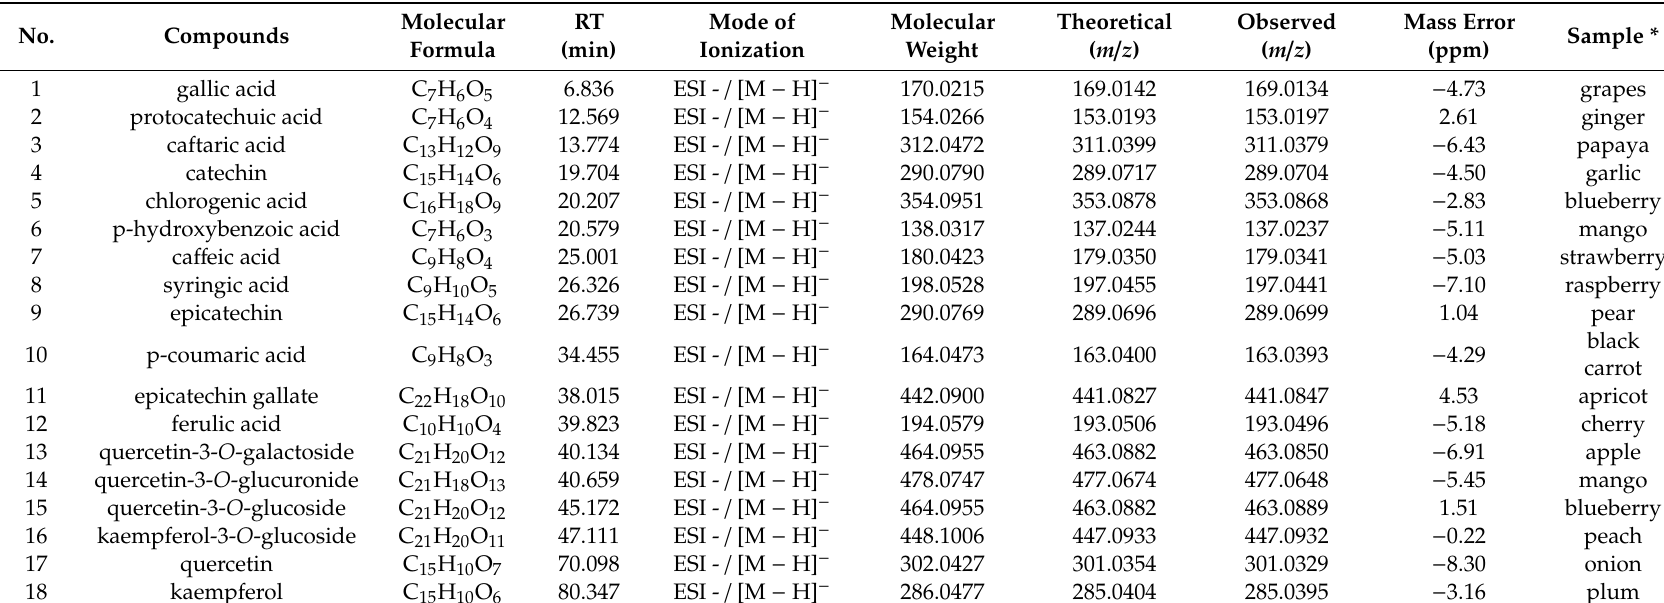
Table 3. Identification of targeted phenolic compounds by LC-ESI-QTOF /